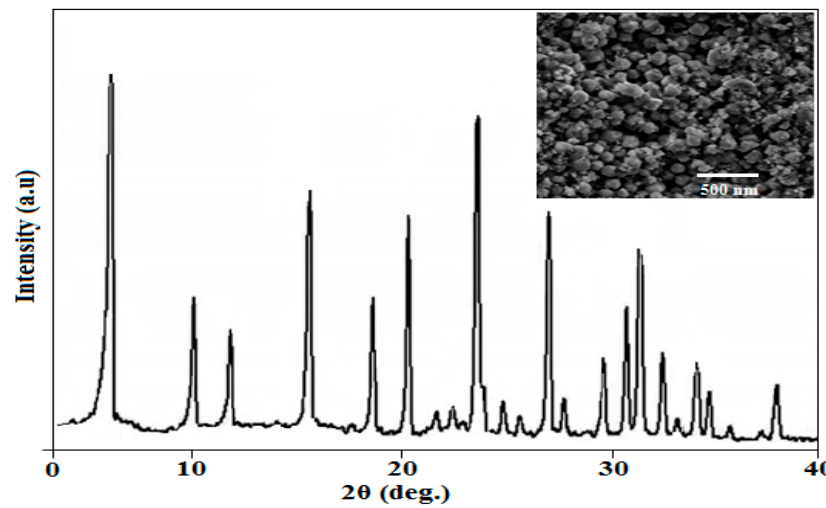
Figure 3. XRD and SEM results of the synthesized nano-size Y-zeolite. Table 3. Chemical composition of the synthesized nano NaY-zeolite.